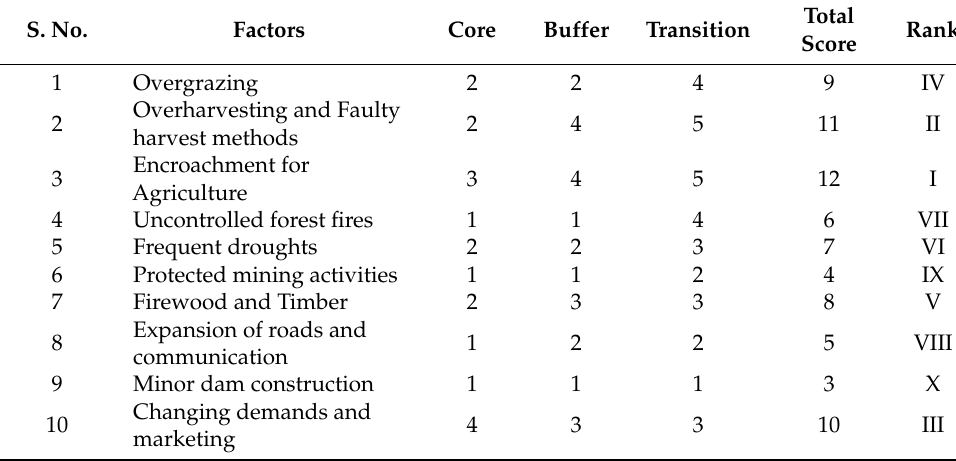
Table 2. Ranking of threats to WEPs in AABR, Central India (scored on 1–5 point Likert scale N = 332, Arabic letter denotes score, Roman letters indicate